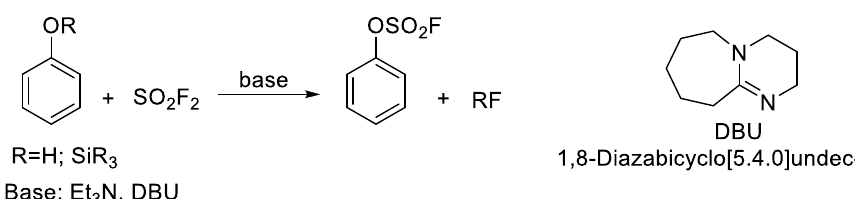
Figure 2. A general scheme for SuFEx-based synthesis of fluorosulfates.